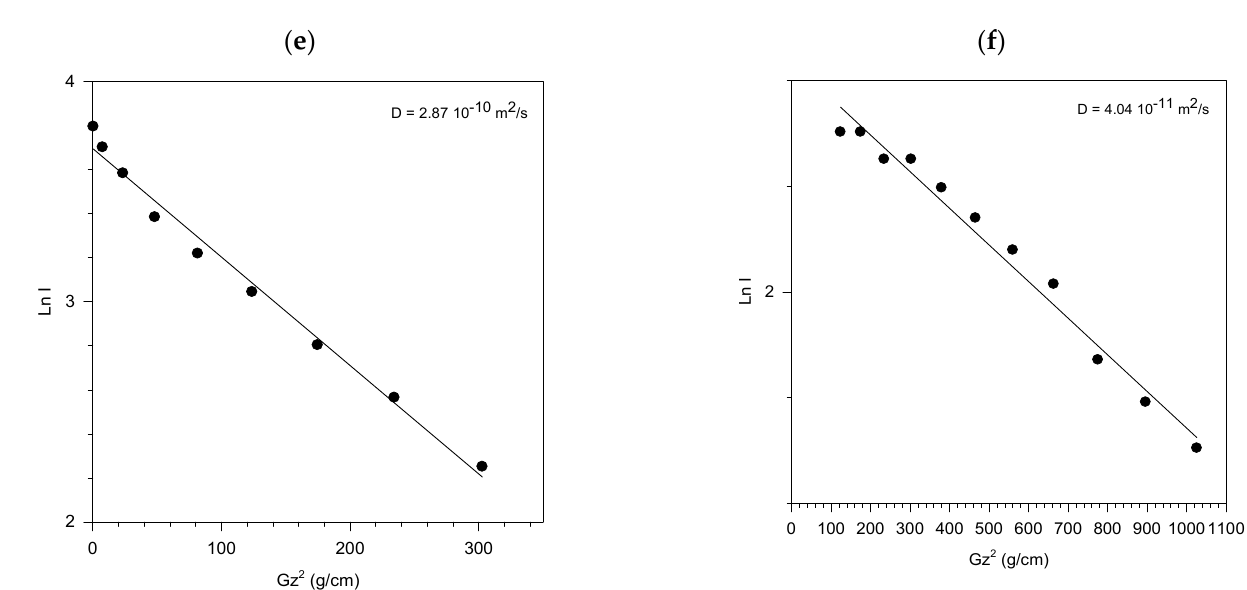
Figure 5. Diffusion curves extracted from the DOSY on CETS peaks. ( a ) CETS peak at 0.9 ppm: fresh NP. ( b ) CETS peak at 0.9 ppm: NP after 6 months (right peak). ( c ) CETS peak at 0.9 ppm: NP after 6 months (left peak). ( d ) CETS peak at 2.3 ppm: fresh NP. ( e ) CETS peak at 2.3 ppm: NP after 6 months (right peak). ( f ) CETS peak at 2.3 ppm: NP after 6 months (left